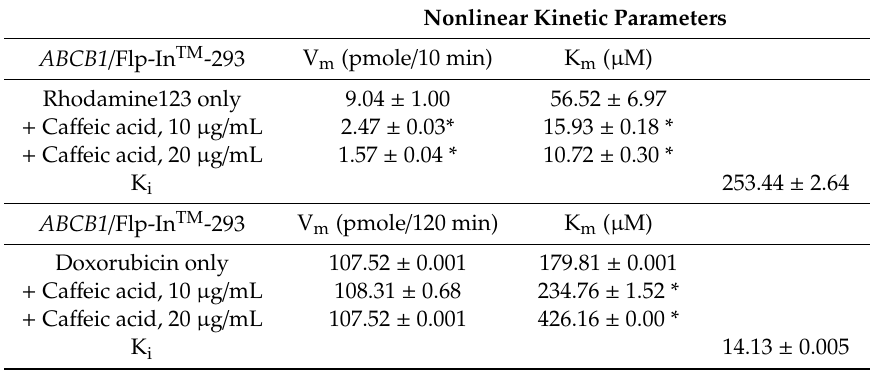
Table 1. The e ff ects of ca ff eic acid on the transport of rhodamine123 and doxorubicin by human